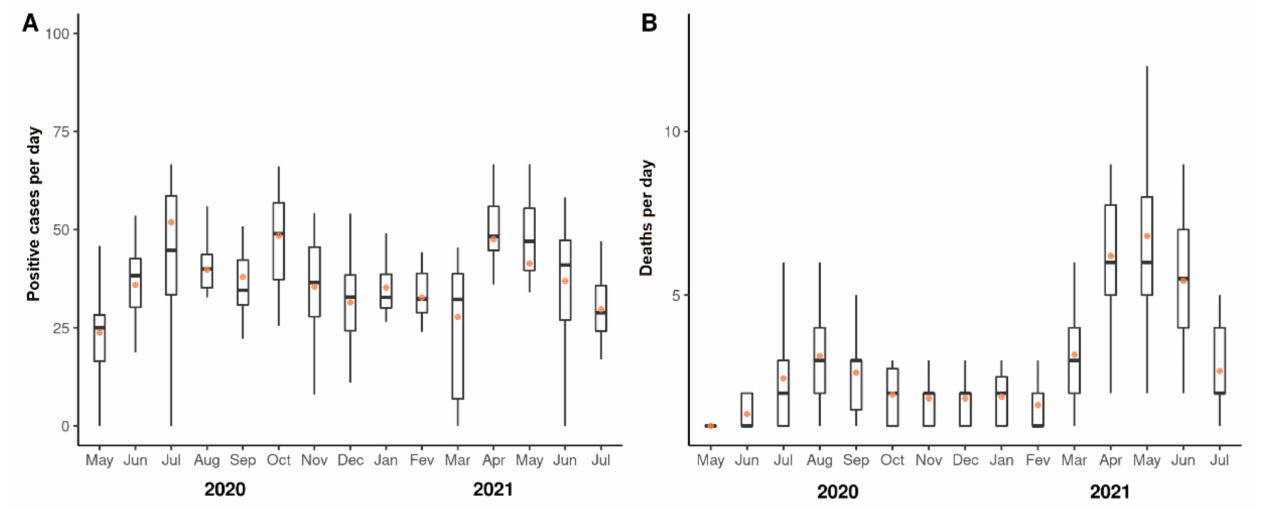
Figure 1. Fluctuations of COVID-19 cases and deaths due to COVID-19 during the period of study. ( A ) numbers of cases of COVID-19 per day during the period of study. ( B ) numbers of deaths due to COVID-19 per day during the period of study. Dots represent means. Horizontal bars represent